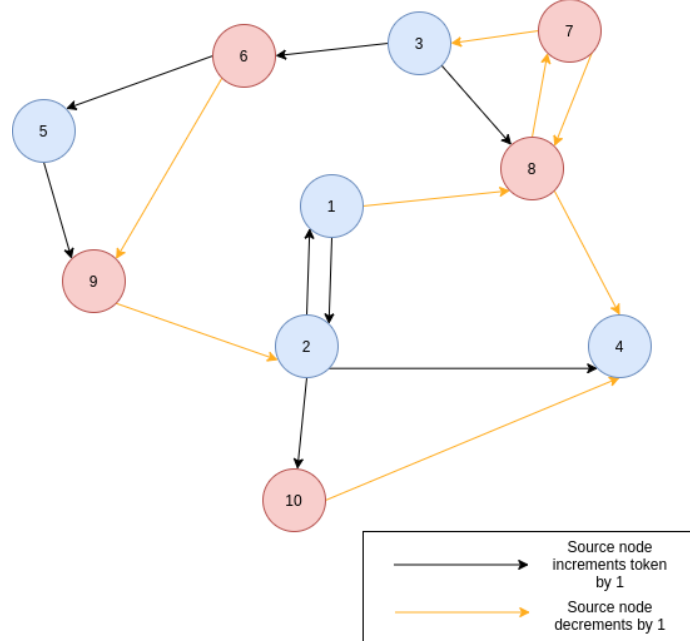
Figure 9. Ten-node network depicting the token modification and